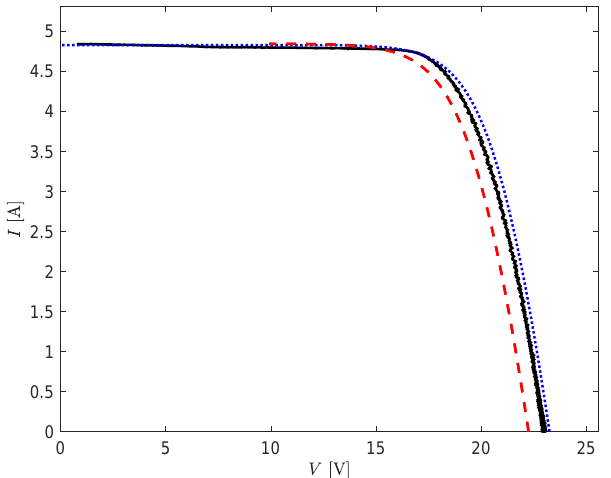
Figure 8. Electrical characteristics of a single PV module obtained experimentally (black line) in Turin (Northern Italy) and by solving the one- (dashed red line) and the three-dimensional (dotted blue line) models when the cooling is active (flow rate of 30 L/h for each module) at G = 1023 W m − 2 , T a = 287.45 K, and inlet water temperature T in = 294.45